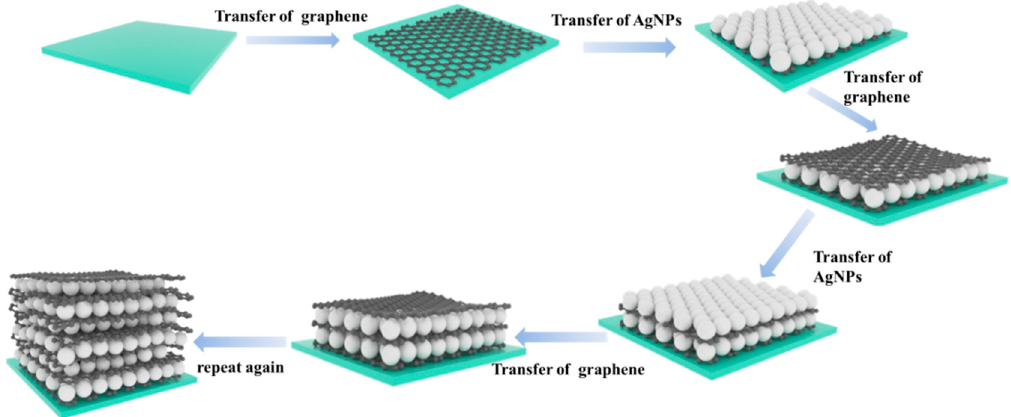
Figure 1. Schematic illustration of the fabrication process of the proposed multilayer substrate.